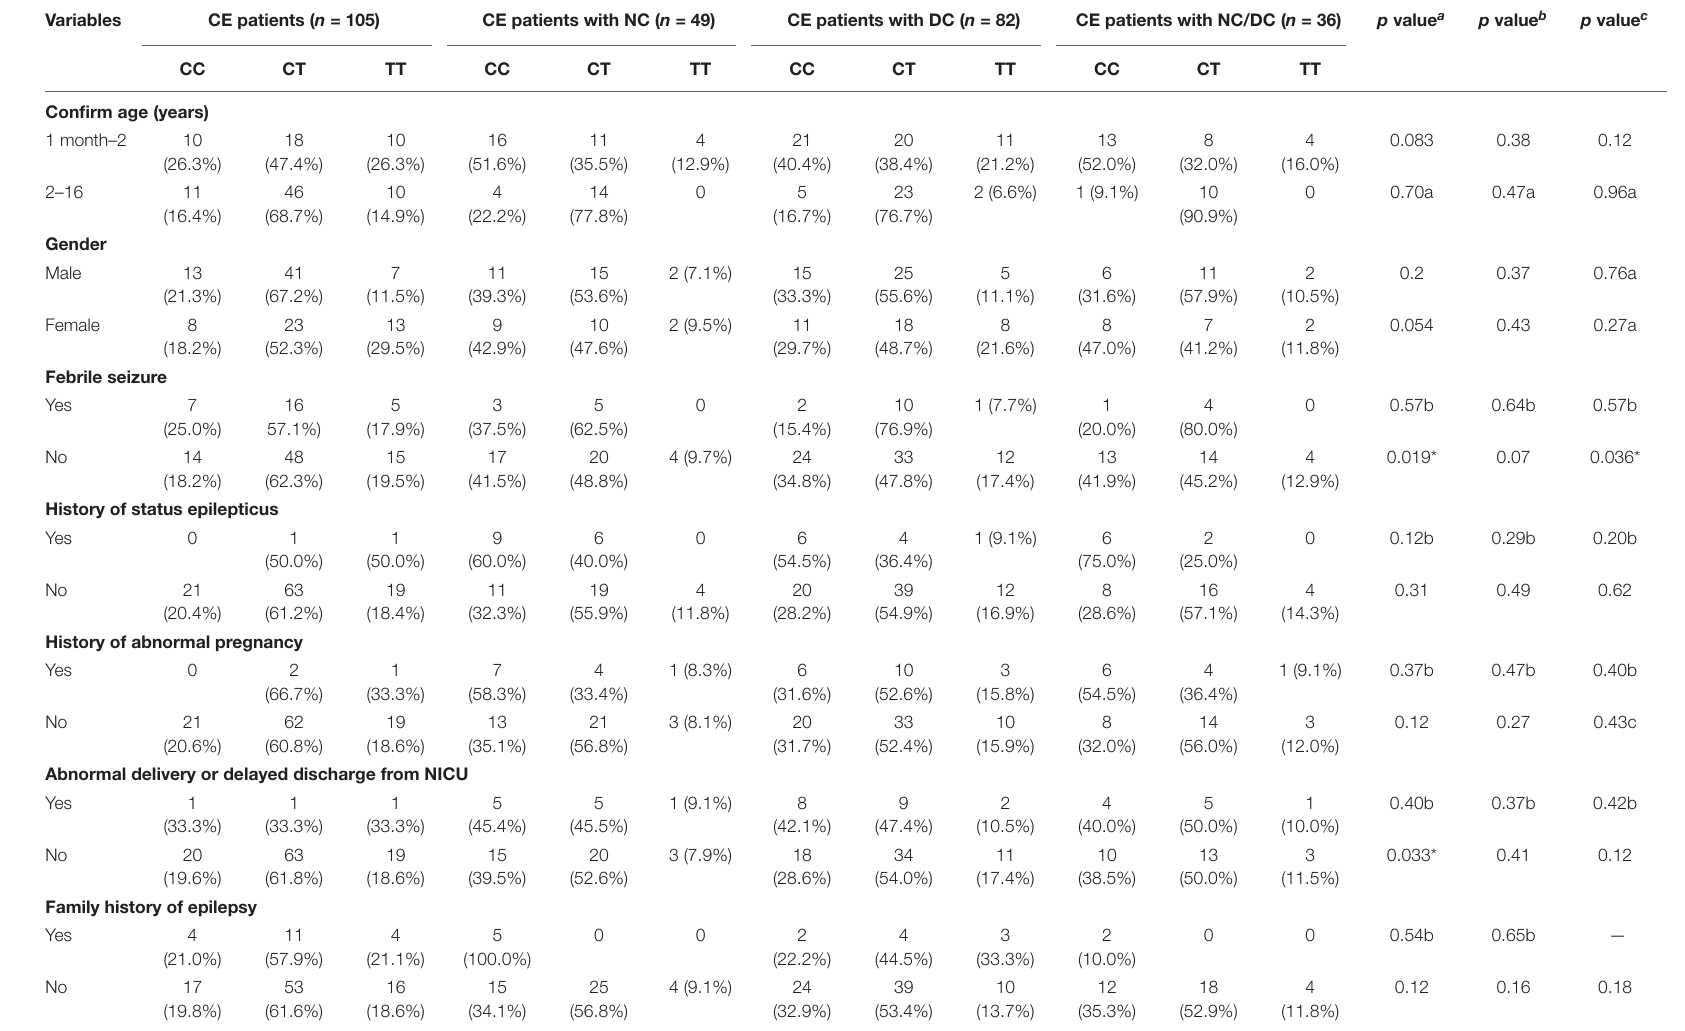
a p-value obtained from CE patients with NC group (n = 49) versus CE patients group (n = 105). b p-value obtained from CE patients with DC group (n = 82) versus CE patients group (n = 105). c p-value obtained from CE patients with NC/DC group (n = 36) versus CE patients group (n = 105). abc, comparison of case number between TT and CC + CT genotypes using chi-square with Yate’s correction, Fisher‘s exact test, and Pearson chi-square test, respectively. *p < 0.05 versus CE patients